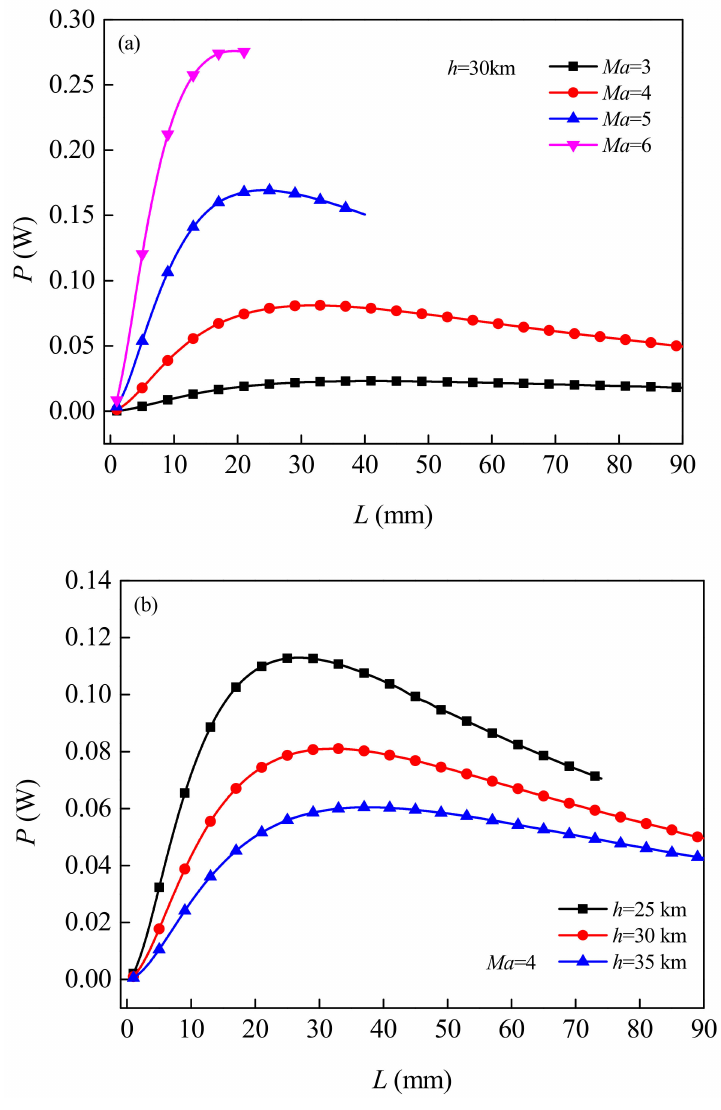
Figure 7. Variation of output power of TEGs changing with the length of the TE leg under different flight Mach Numbers ( a ) and flight altitudes ( b